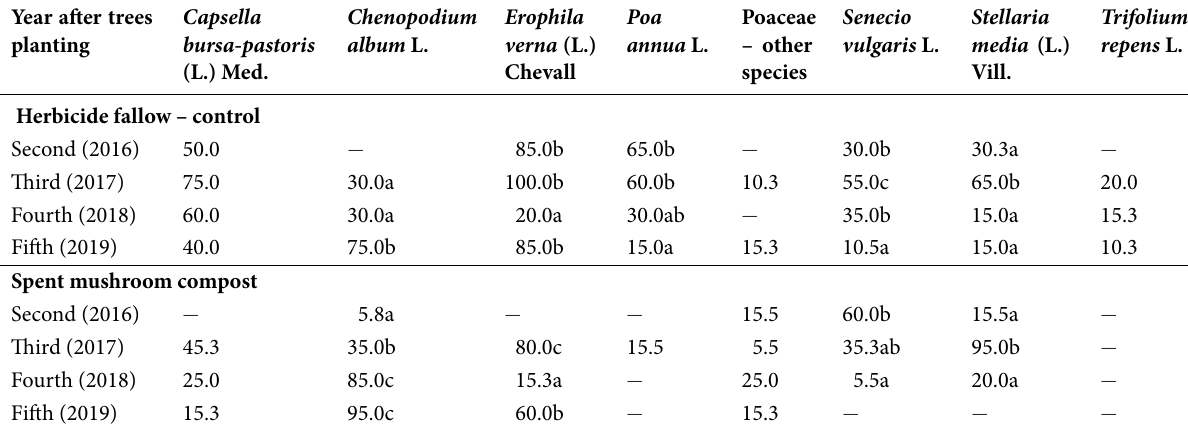
“ − ” – up to 1% soil surface coverage without statistical estimation. Within individual columns, the means denoted by different letters differ significantly according to Duncan’s test at a confidence level of 95%; the means without letters are nonsignificant.